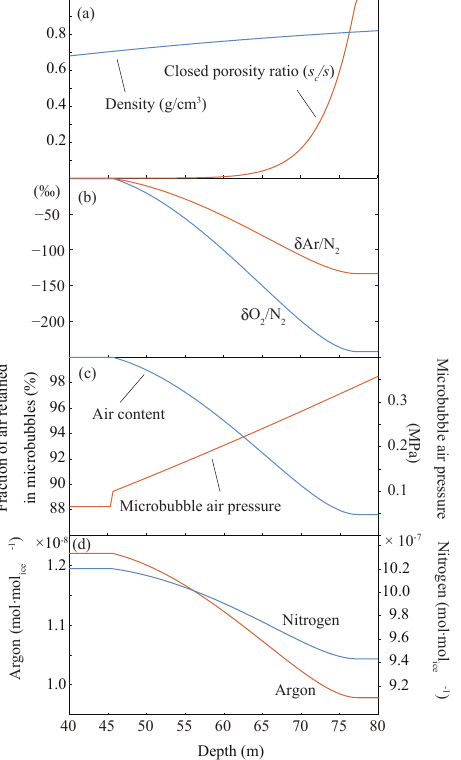
Figure 9. Simulated δ Ar / N 2 vs. depth relationship in the mi- crobubbles with a temperature of − 31 ◦ C, accumulation rate of 0.24miceyear − 1 , and microbubble contribution of 2%. (a) Den- sity and closed porosity ( s c ) . (b) δ Ar / N 2 and δ O 2 / N 2 . (c) Air con- tent and air pressure in the microbubbles. (d) Nitrogen and argon concentrations. 3 % of the air content (6.53226 × 10 − 5 mol × 0.01) per 1